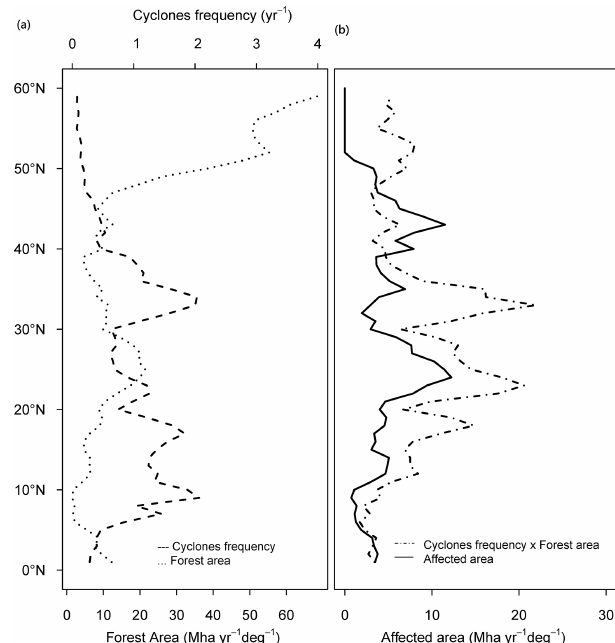
Figure A2. Contribution of return frequency and forest cover to the affected area: (a) the zonal average of forest coverage (dot- ted line; km 2 ) and the return frequency (dashed line; yr − 1 ) of tropical cyclones from 0 to 60 ◦ N averaged over East Asia, as defined in this study; (b) zonal average of the interaction be- tween return frequency and forest cover, calculated by multiply- ing the return frequency with the forest cover (dot–dash line; km 2 yr − 1 ) and the estimated zonal average of the annual affected forest area (full line;km 2 yr − 1 ). Correlations between return fre- quency and affected area (Pearson correlation coefficient =− 0.35; p value < 0.01; n = 60), forest cover and affected area (Pearson correlation coefficient = 0.089; p value = 0.5; n = 60), and fre- quency times cover and affected area (Pearson correlation coeffi- cient = 0.44; p value < 0.01; n = 60). The latter thus correlates best with the zonal variation in the affected area and was therefore shown in panel (b) . Results are shown for affected areas defined as lo- cations within an area extending to 3 times the cyclone width for which the wind exceeded a threshold (definition 3a in Table